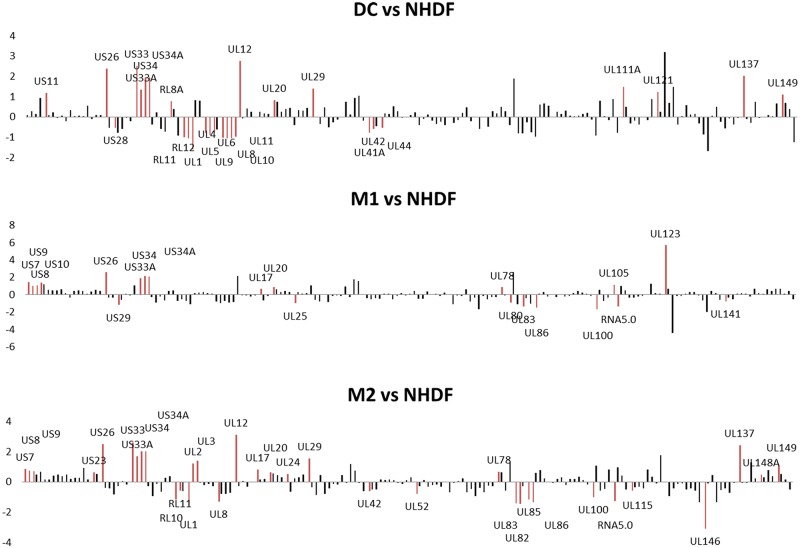
Differential regulation of HCMV gene expression in monocyte-derived DCs, MΦ1 and MΦ2 (MOI5) compared to lytic infection in NHDF fibroblasts (MOI0.16).On the graph is the fold increase or decrease (reflecting genes which are expressed higher/lower in fibroblasts than in primary cell types). Red bars represent significant changes in gene expression between the indicated cell type and NHDF fibroblasts (adjusted p<0.05), black bars indicate modulated genes which did not reach the significance threshold (adjusted p≥0.05).